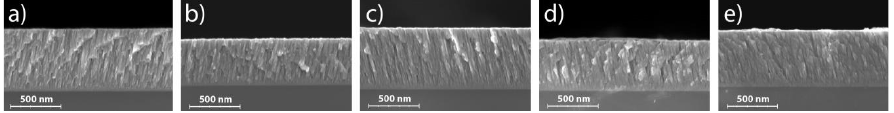
Figure 5. SEM images of a fractured cross-section and the surface for ( a ) point 1, ( b ) point 2, ( c ) point 3, ( d ) point 4 and ( e ) point 5. The images reveal a columnar structure and differences in thickness for all five points.